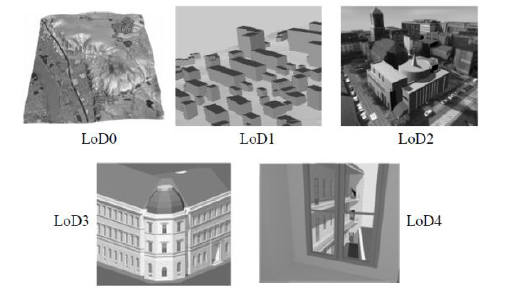
Figure 1. The five level of details (LoD) defined by CityGML (Kolbe et al.,